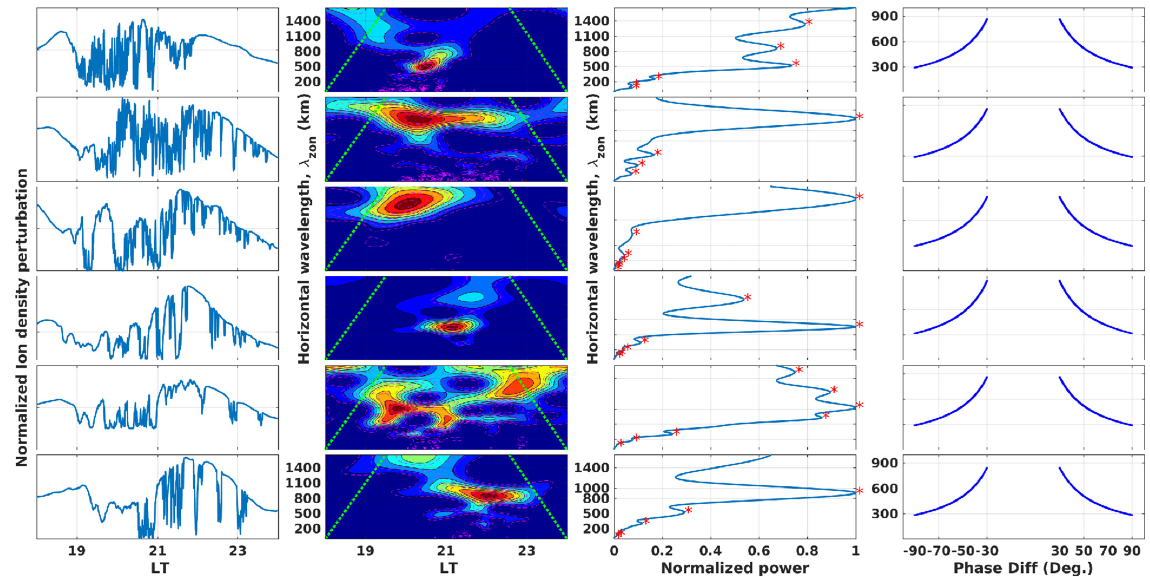
Figure 12. Normalized ion density perturbation ( left panels ) versus LT, contour map of wavelet power of normalized ion density fluctuations versus zonal wavelength and LT ( 2nd column from the left , deep red and blue colors represent dominant and weak power, 95% confidence intervals are represented by magenta color dashed line curves) and time integrated normalized wavelet power of normalized ion density fluctuations versus zonal wavelength ( 3rd column from the left ), and gravity wave zonal wavelength versus phase shift ( 4th column from the left ) on 16 October 2011. The asterisks in the third column represent peak value of time integrated normalized wavelet power.